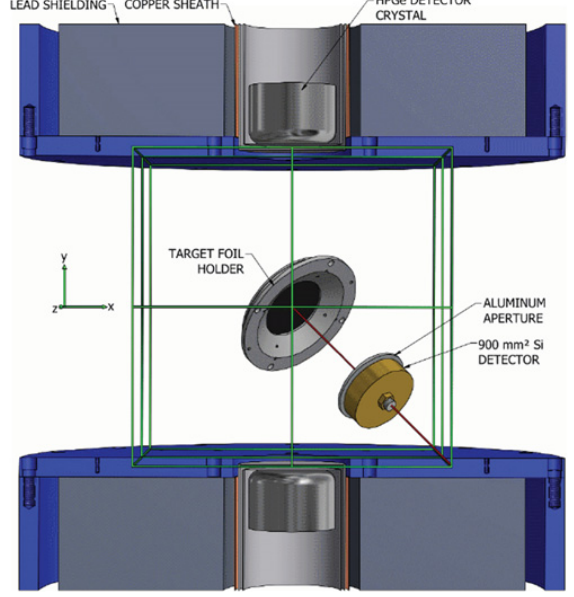
Figure 1. Layout of the Alpha-Gamma target mount showing the detectors. The neutron beam is incident from the right of the image.